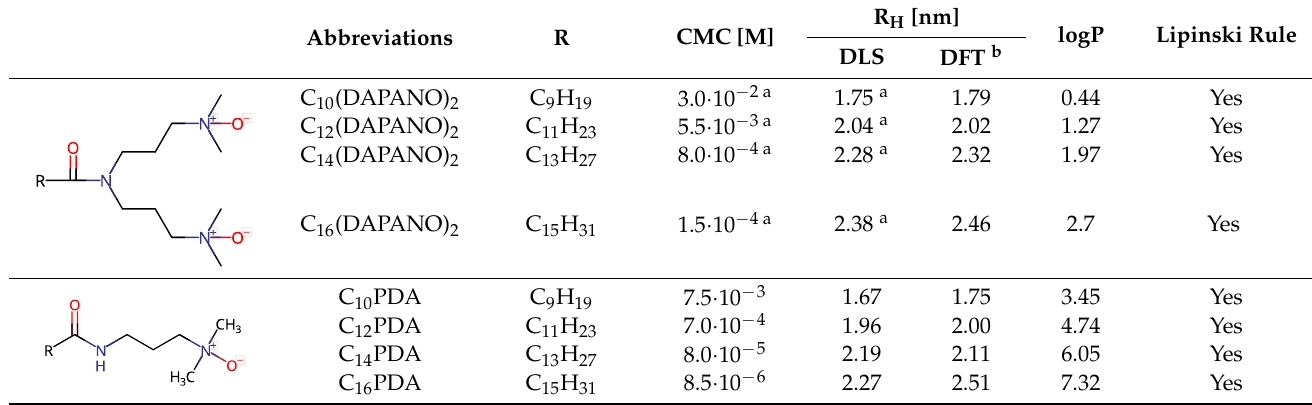
Table 1. Selected properties of the examined surfactants: critical micelle concentrations (CMC), hydrodynamic radius (R H ), the degree of hydrophobicity from the COSMO-RS calculations [defined as the logarithm of the octanol-water partition coefficient (logP)].